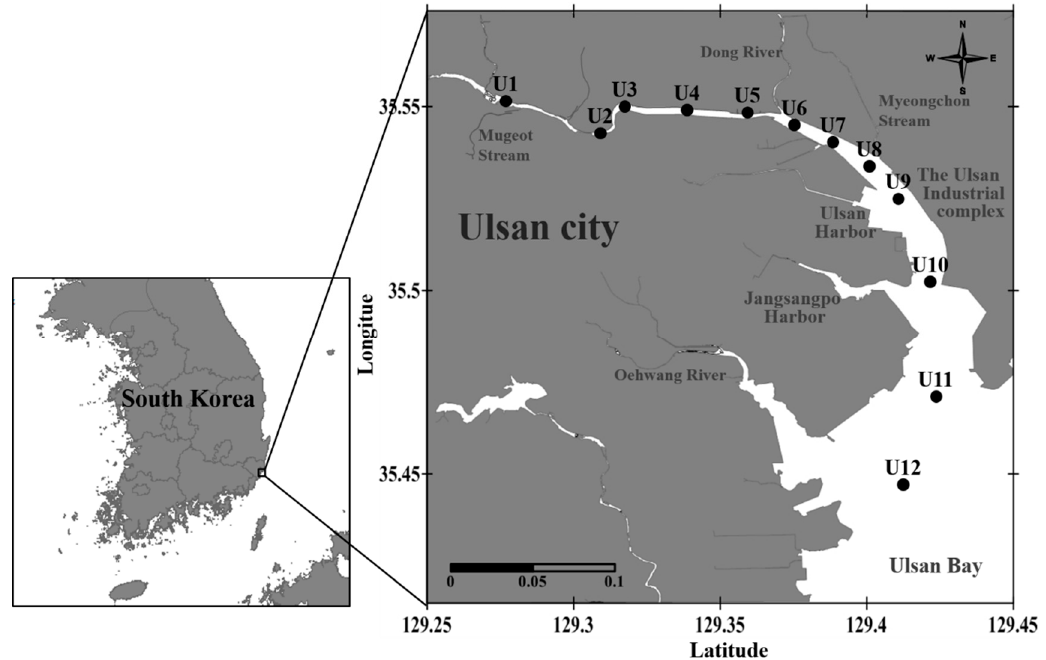
Figure 1. Sampling stations in the Taehwa River estuary in Korea.